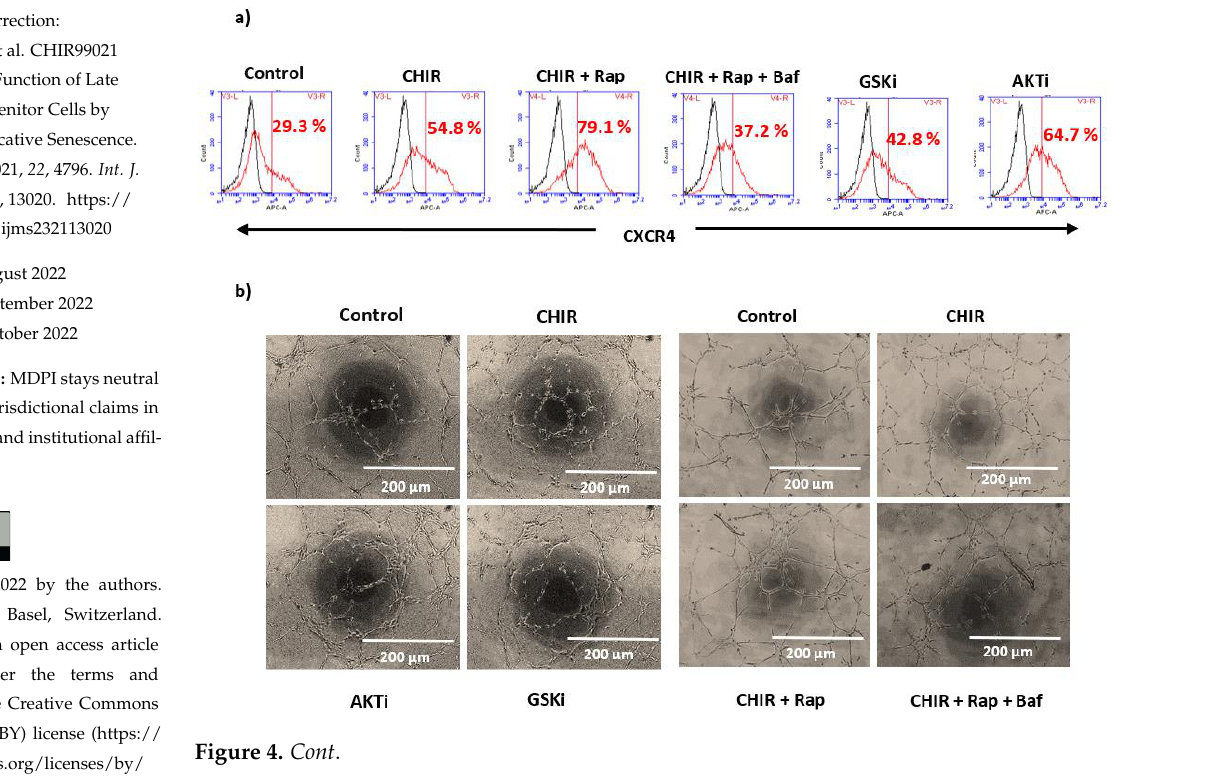
Figure 4. Lysosome activation and autophagy by CHIR99021 expands endothelial functional activ- ity of late EPCs: ( a ) Cells were single treated with CHIR99021 (3 μM), and GSK 3β specific inhibitor (3 μM) for 24 h, and AKT 1/2 inhibitor (3 μM) for 1 h, then su bsequently co-treated with Rapamycin (20 nM) and bafilomycin A1 (5 nM) for 1 h. FACS was performed for gating the population of non- stained cells as a negative control. The fraction of positively stained cells was determined by com- parison with non-stained cells. The fraction of positively-stained cells is indicated by the positive peaks (red line indicates cells stained with each antibody, and black lines indicate the negative con- trol). ( b ) Endothelial functional activity of EPCs was established using vascular network formation. Cells treated with CHIR99021 (3 μM), AKT 1/2 inhibitor (3 μM), GSK 3β inhibitor (3 μM) either in presence or absence of Rapamycin (20 nM) and Bafilomycin A1 (5 nM) for 6 h. The vascular structure was visualized using a light microscopy, the branches were quantified using ImageJ. ( c,d ) The num- ber of branches were also quantified. Data are presented as mean ± standard error of the mean (SEM). The results are considered statistically significant at * p < 0.05; ** p < 0.01; *** p < 0.001 when compared to untreated groups. (Baf-bafilomycin A1, Rap- Rapamycin, AKTi- AKT inhibitor, GSKi- GSK inhibitor).